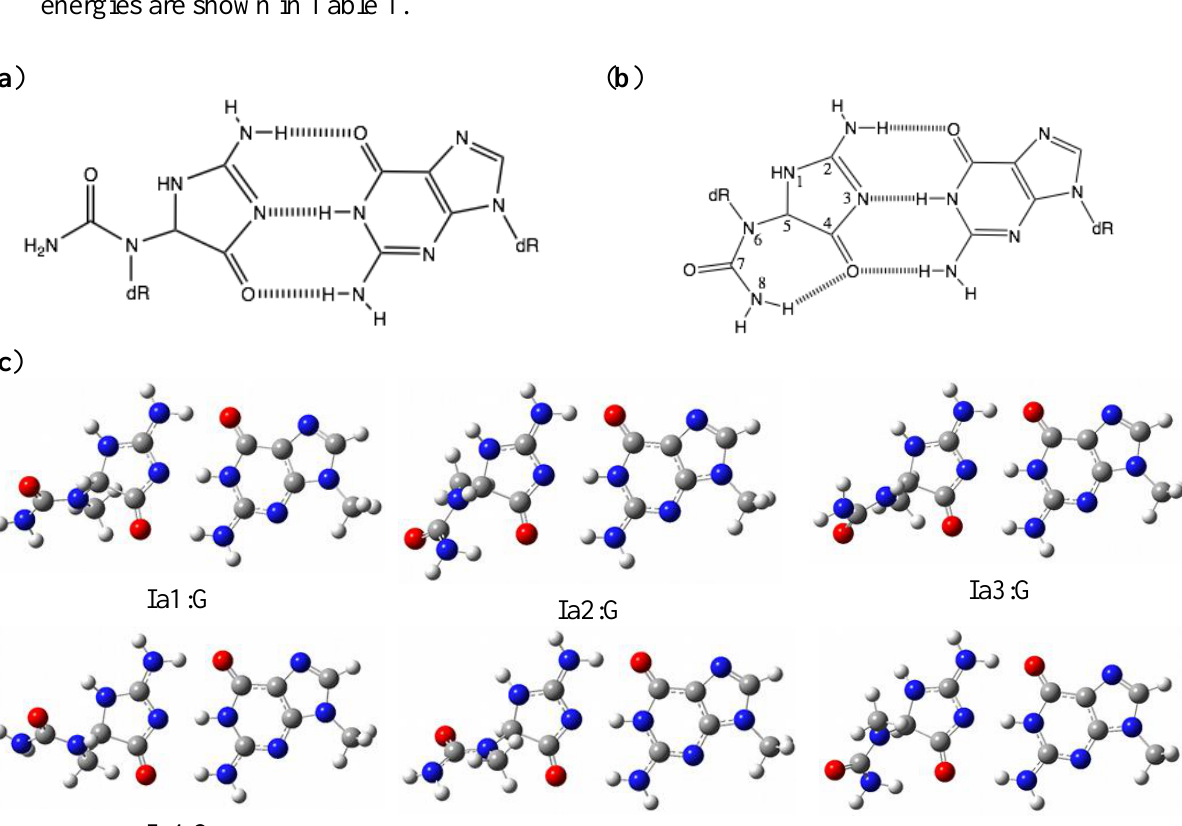
Figure 1. The Ia:G base pairs. ( a ) The proposed Ia:G base pair. ( b ) The proposed Ia:G base pairs and the associated hydrogen bonds. This numbering is the same as used in reference 13. ( c ) The geometries of Ia1:G-Ia8:G optimized by ab initio calculation. The stabilization energies are shown in Table